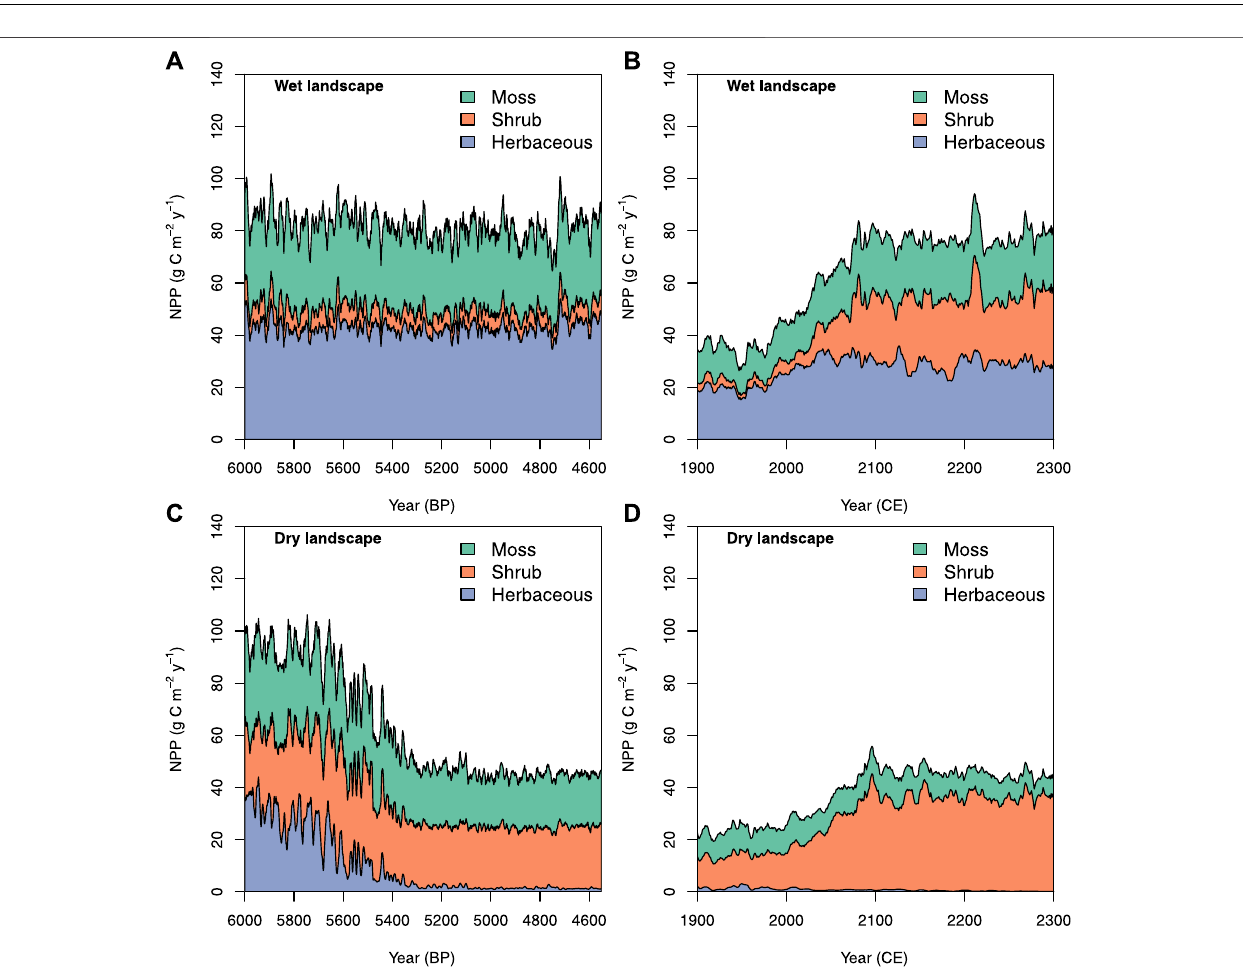
FIGURE 4 | Modeled net primary productivity for moss, shrub, and herb plant functional types in the wet (top) and dry (bottom) landscape scenarios for two time periods: 6,000 BP – 4,550 BP (left) and between 1900 and 2300 CE (right). (A) Wet landscape scenario, 6000 - 4550 BP; (B) Wet landscape scenario, 1900 - 2300 CE; (C) Dry landscape scenario, 6000 - 4550 BP; (D) Dry landscape scenario, 1900 - 2300 CE.